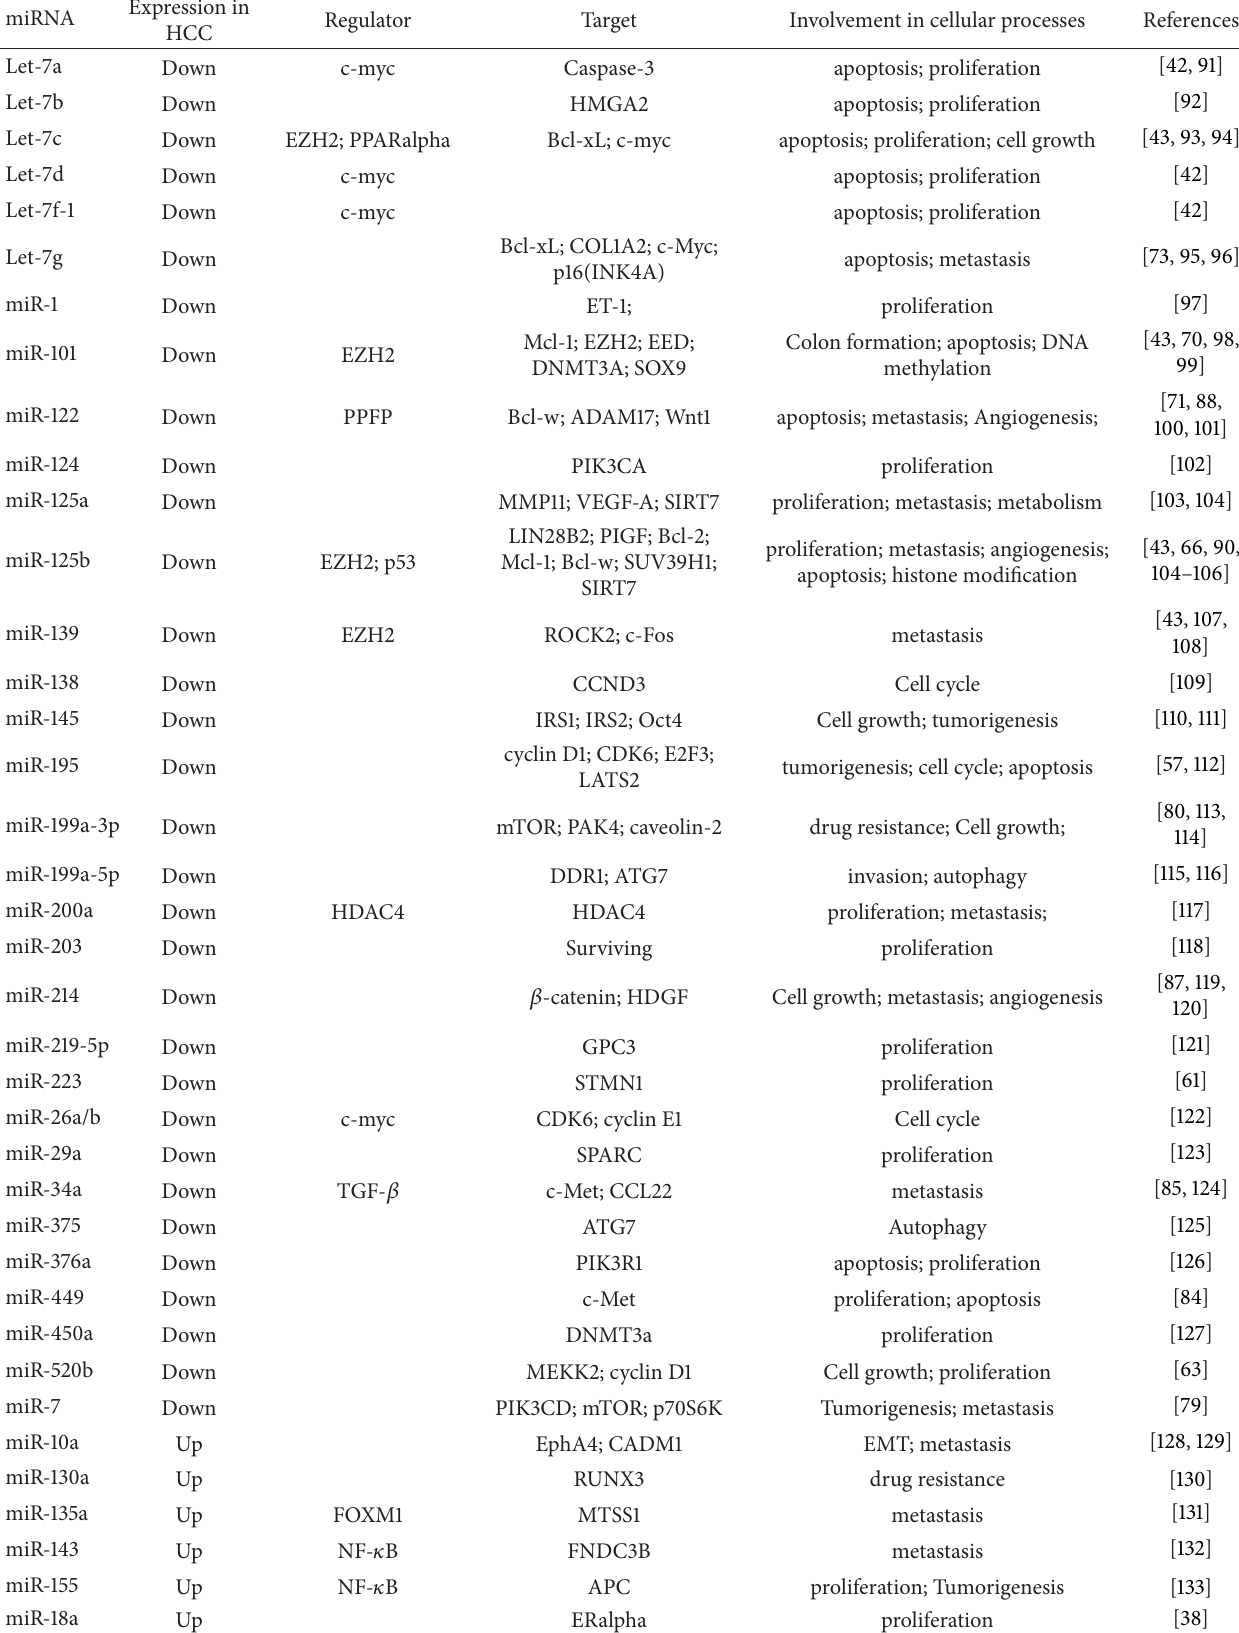
Table 1: MiRNAs deregulated in hepatocellular carcinoma